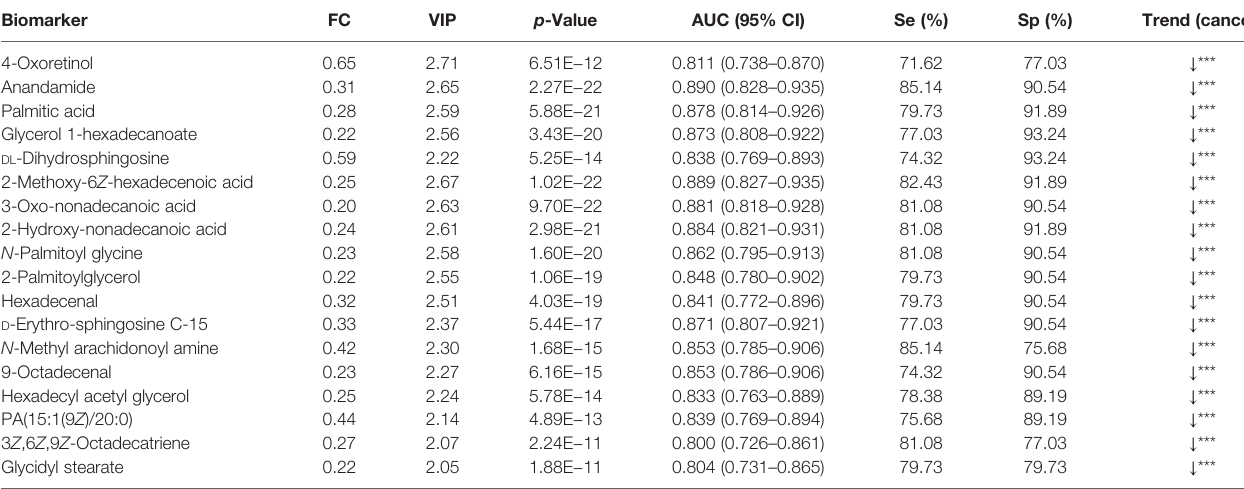
TABLE 3 | Detection of 18 selected lipid metabolites as potential biomarkers for the diagnosis of PCa with PSA levels at gray zone of 4 – 10 ng/ml. Biomarker